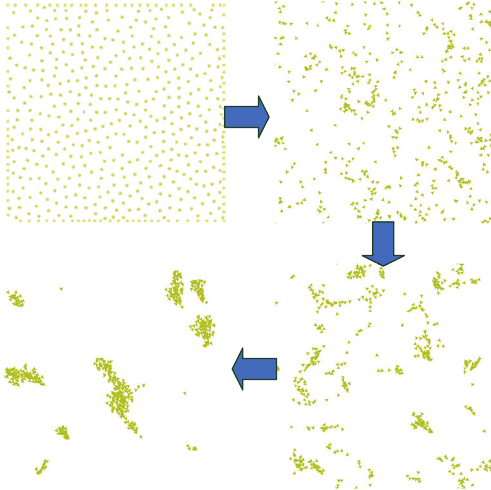
Figure 4: The processes of the